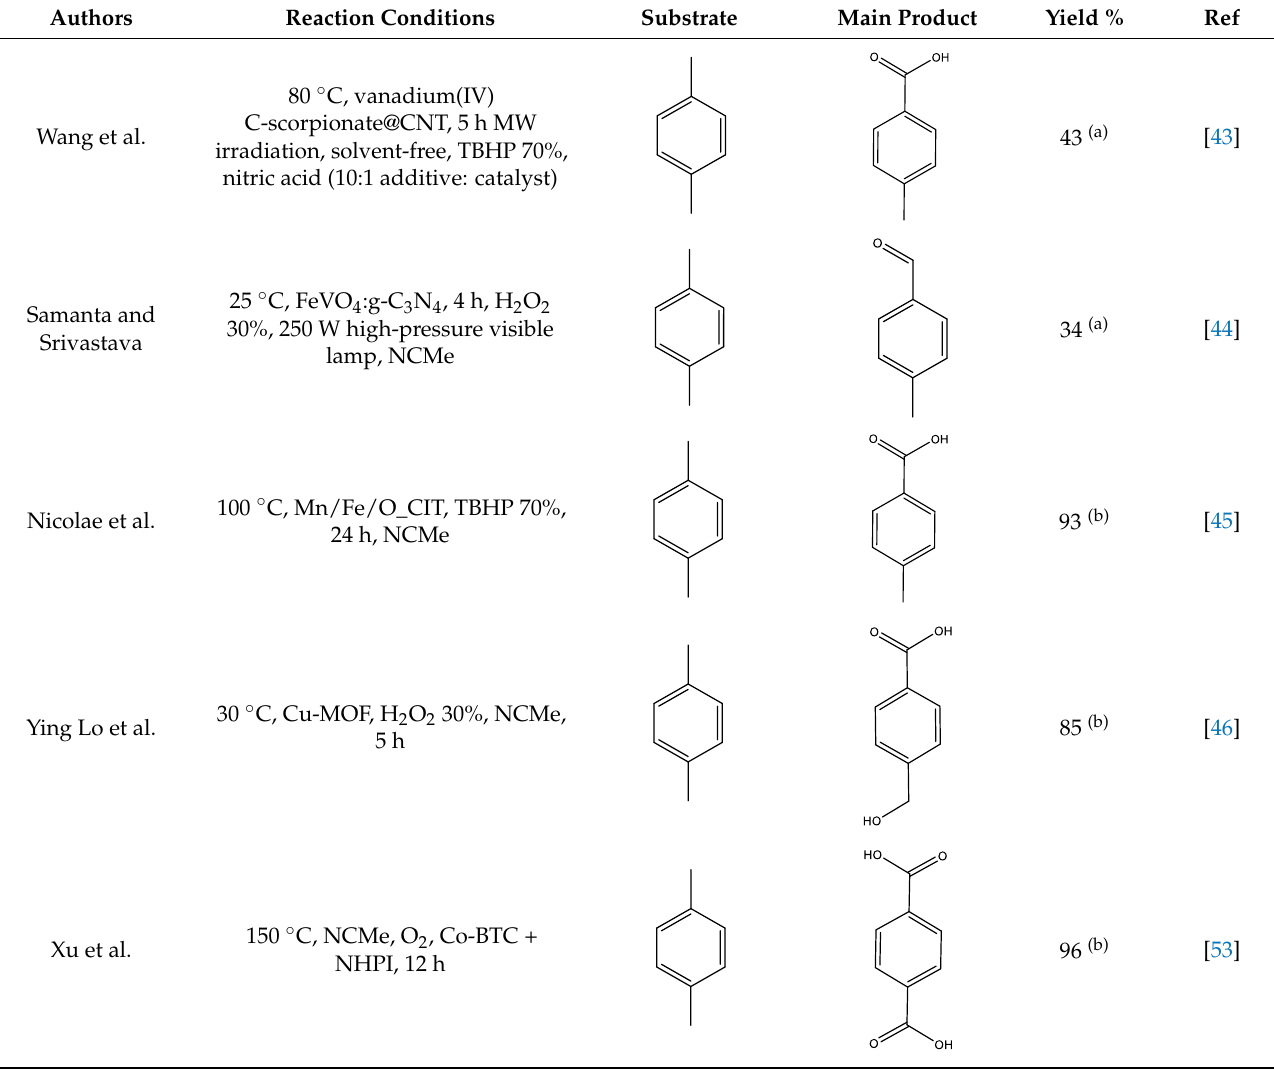
Table 2. Reaction conditions and best results for heterogeneous catalysts, focusing on the oxidation of p- xylene.